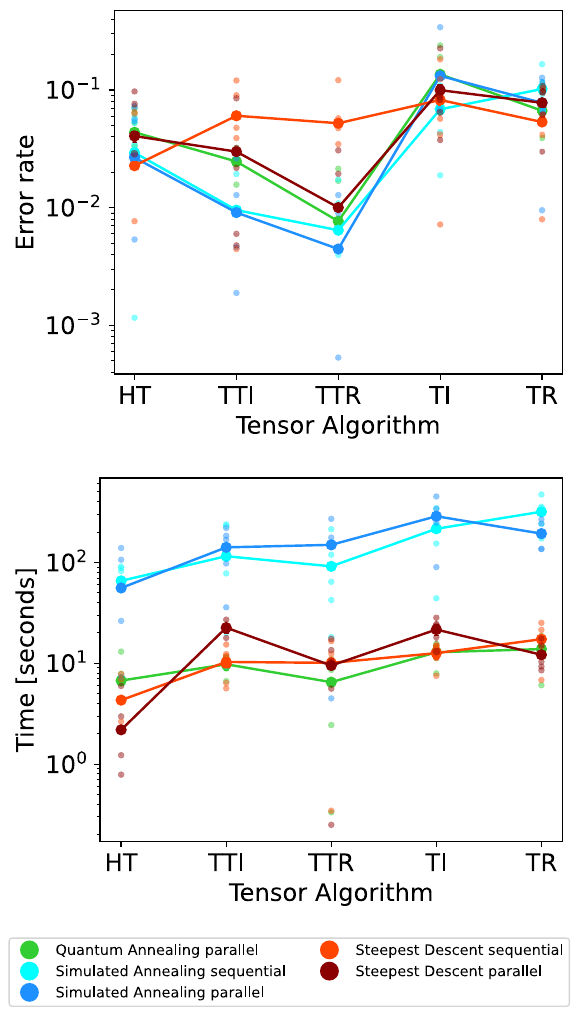
Figure 9. Classical (simulated annealing and steepest descent algorithms) and quantum annealing implementations (D-Wave 2000Q) of the five tensor algorithms Hierarchical Tucker (HT), Tensor Train Iterative (TTI), Tensor Train Recursive (TTR), Tucker Iterative (TI), and Tucker Recursive (TR). The tensor parameters are fixed to be rank 3, dimension size 12, and order 4. For D-Wave we report QPU time (in particular, qpu- access-time), whereas for classical computations we report CPU process time. Log scale on the y-axes. Each dot is one tensor (5 tensors per algorithm), while lines connect the mean values for each